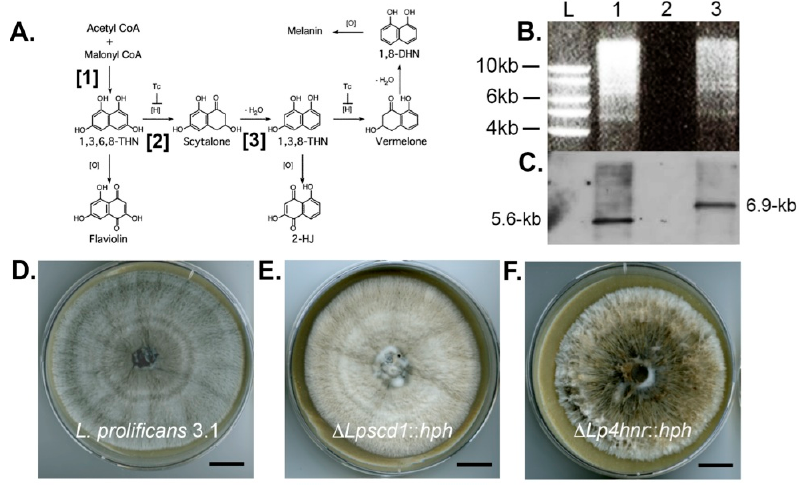
Figure 1. Cont. Figure 1.